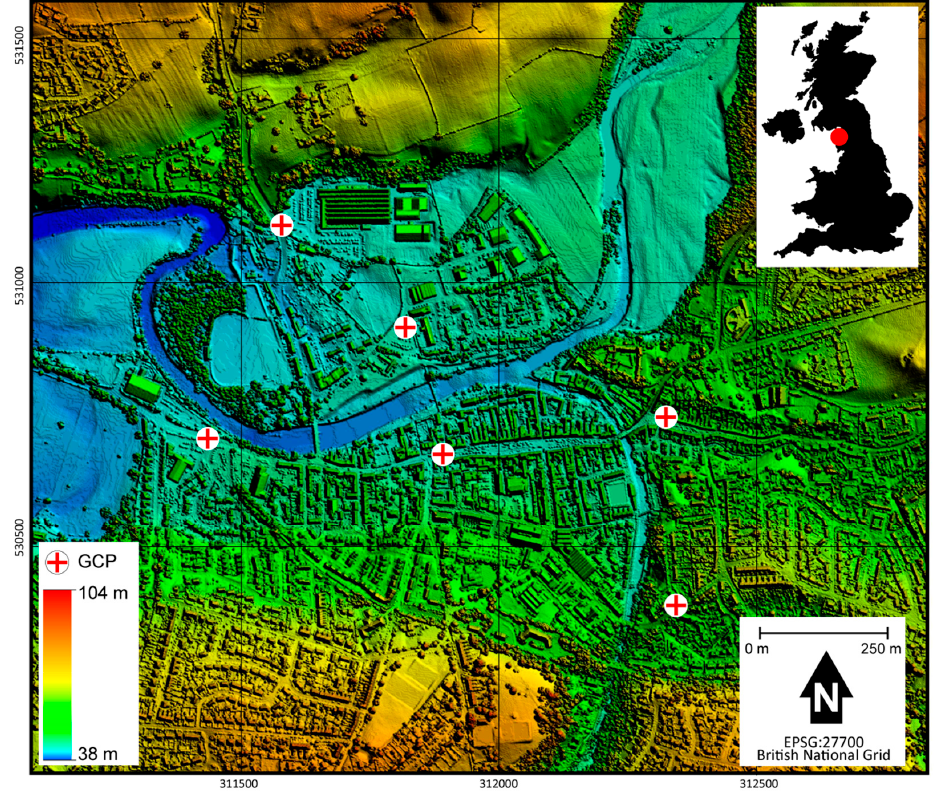
Figure 1. Diagram showing the location of the case study area (Cockermouth) in UK. GCP stands for ground control point. Elevation values are in meters above sea level. Contains public sector information licensed under the Open Government Licence v3.0 [28].